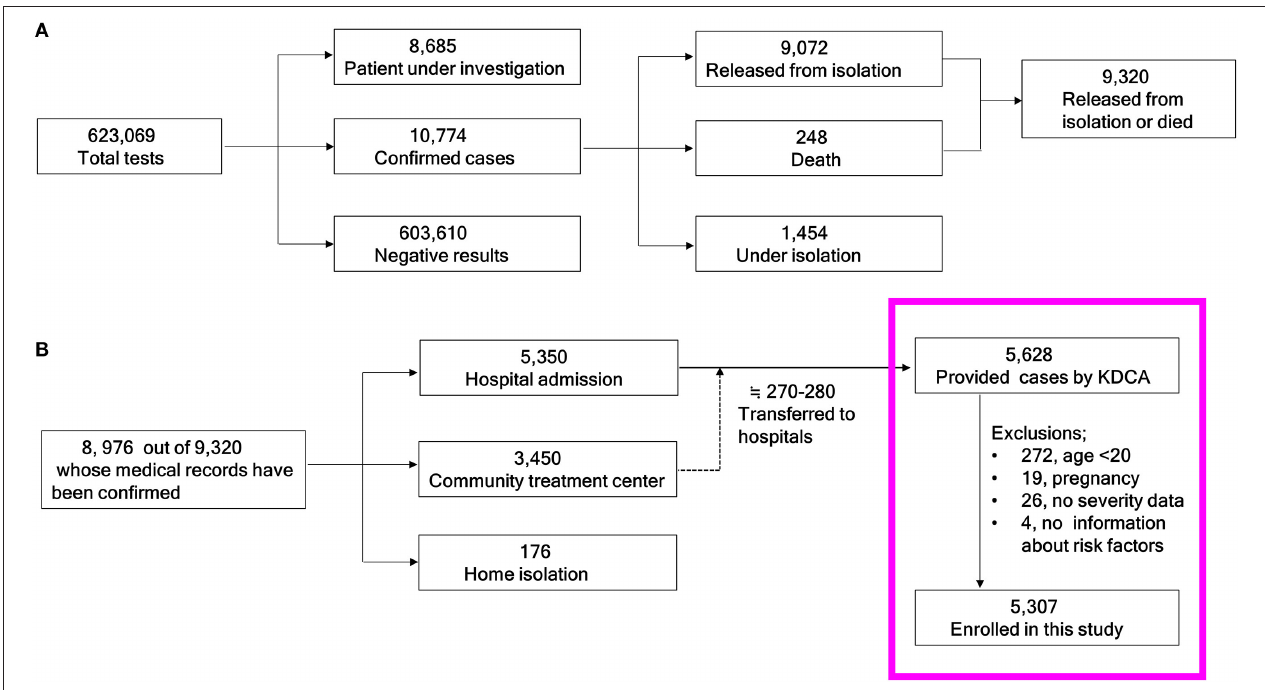
FIGURE 1 | Schema of the study population. (A) From the total number of people tested for COVID-19 to the cumulative numbers of those who were released from isolation or died. (B) Flow chart of the current study candidates. KDCA, Korea Disease Control and Prevention Agency.